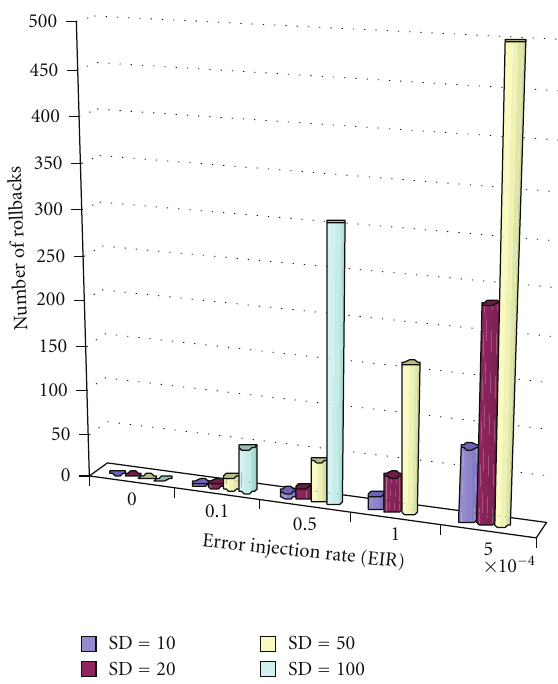
Figure 28: E.I.R e ff ect on rollback (benckmarks of group